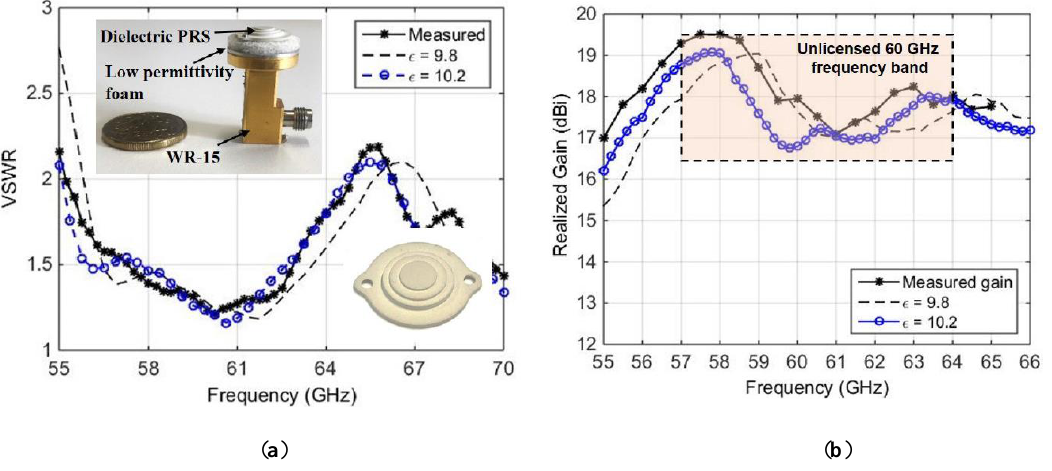
Figure 6. Simulated and measured results of RCA with stepped PRS: ( a ) VSWR; ( b ) Gain